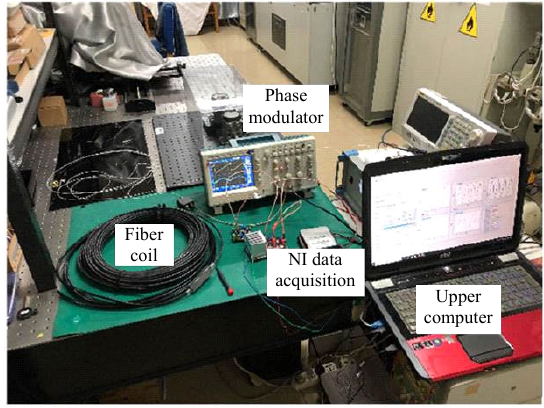
Fig. 4 Physical diagram of the